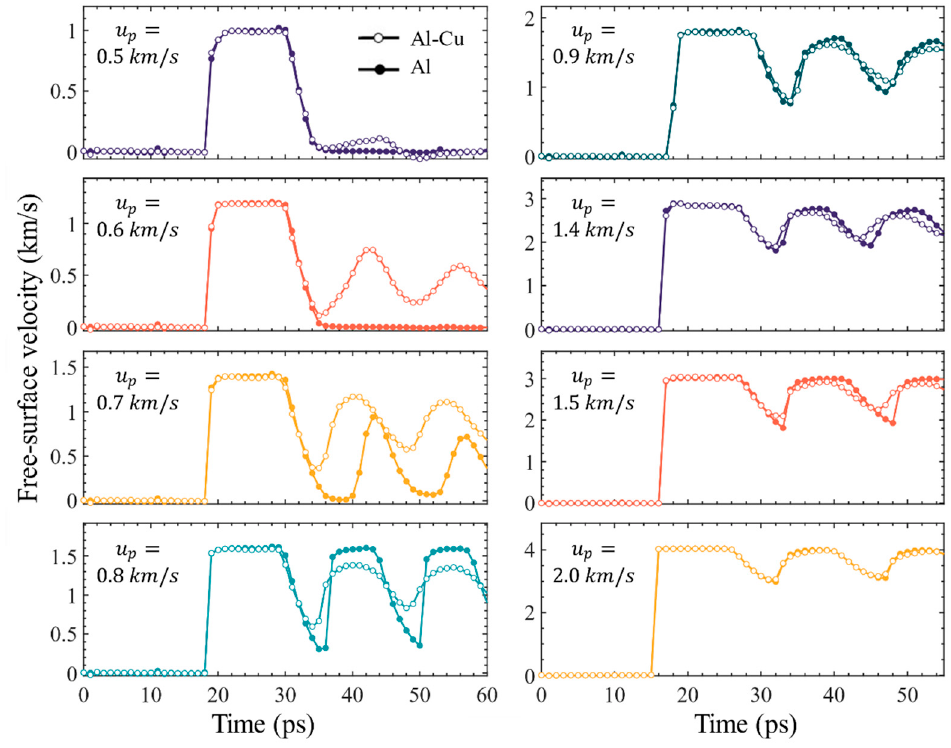
Figure 2. Time evolutions of free surface velocity for the crystal with Cu inclusion and the perfect crystal at various piston velocities. The solid circles represent the perfect crystal, and the open circles represent the crystal with inclusion.